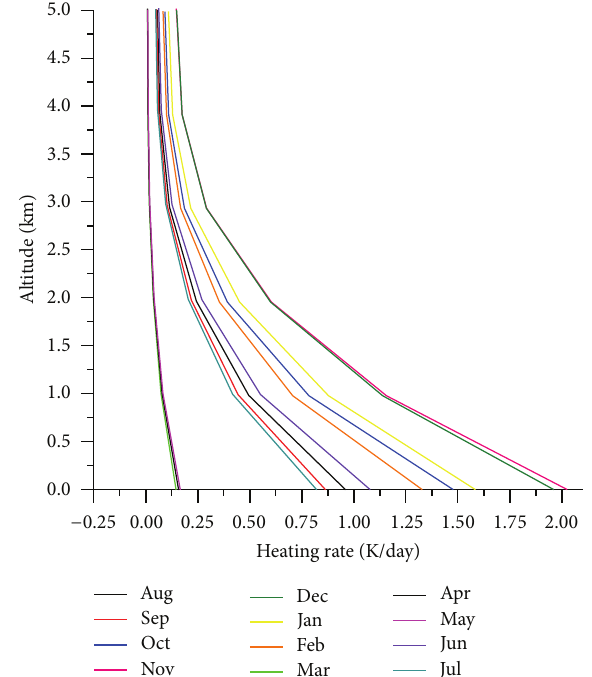
Figure 5: BC heating rates as a function of altitude for each month from August 2010 to July